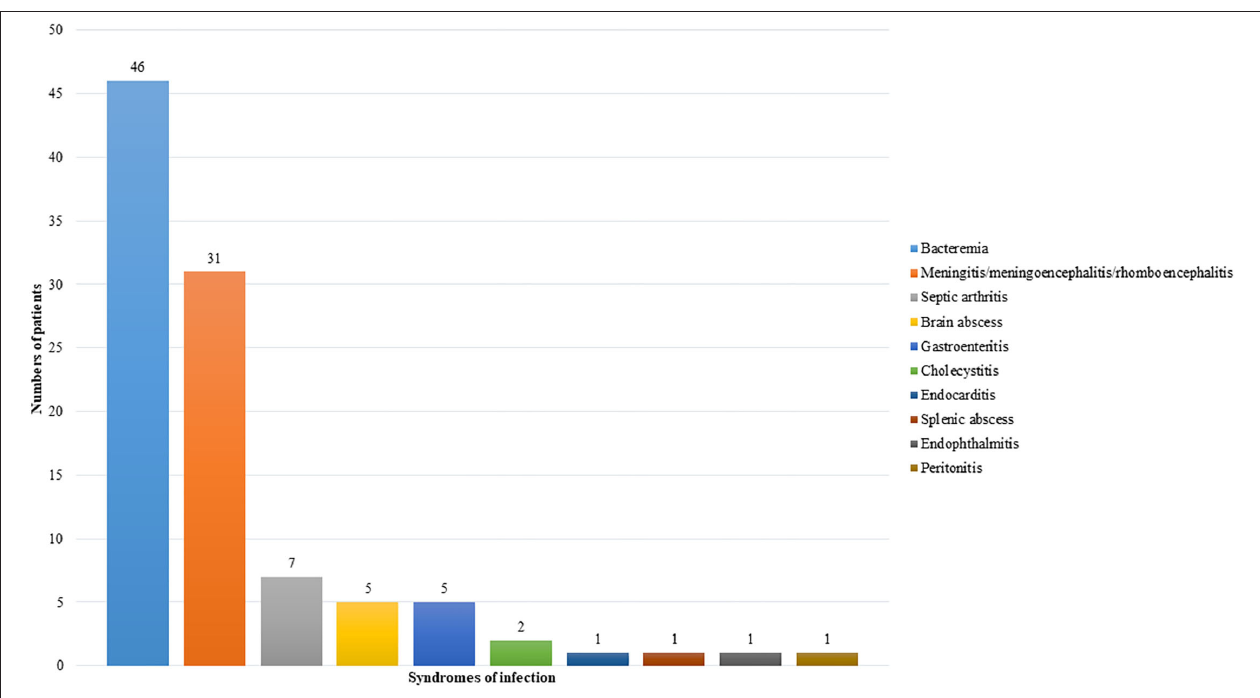
FIGURE 2 | Types of listeria infection in patients on targeted